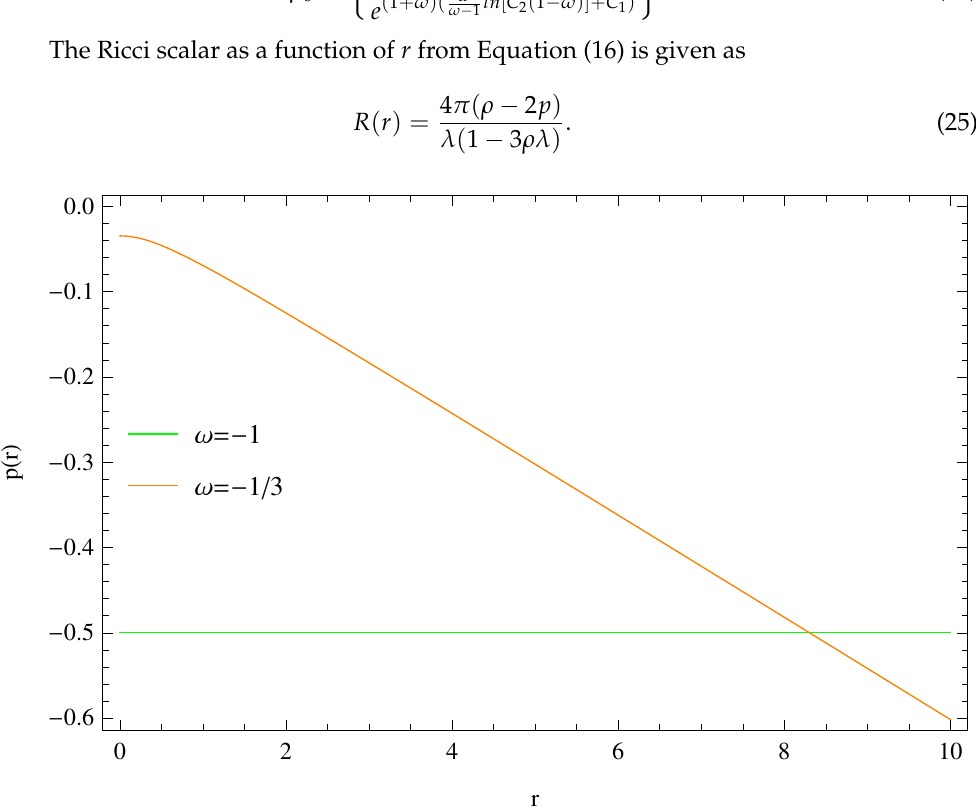
Figure 3. The pressure is plotted against the radial parameter r , for both dark energy matter ( ω = − 1) and quintessence field ( ω = − 1/3), for the values of constants C 1 = 0.01, C 2 = 0.5, C 3 =